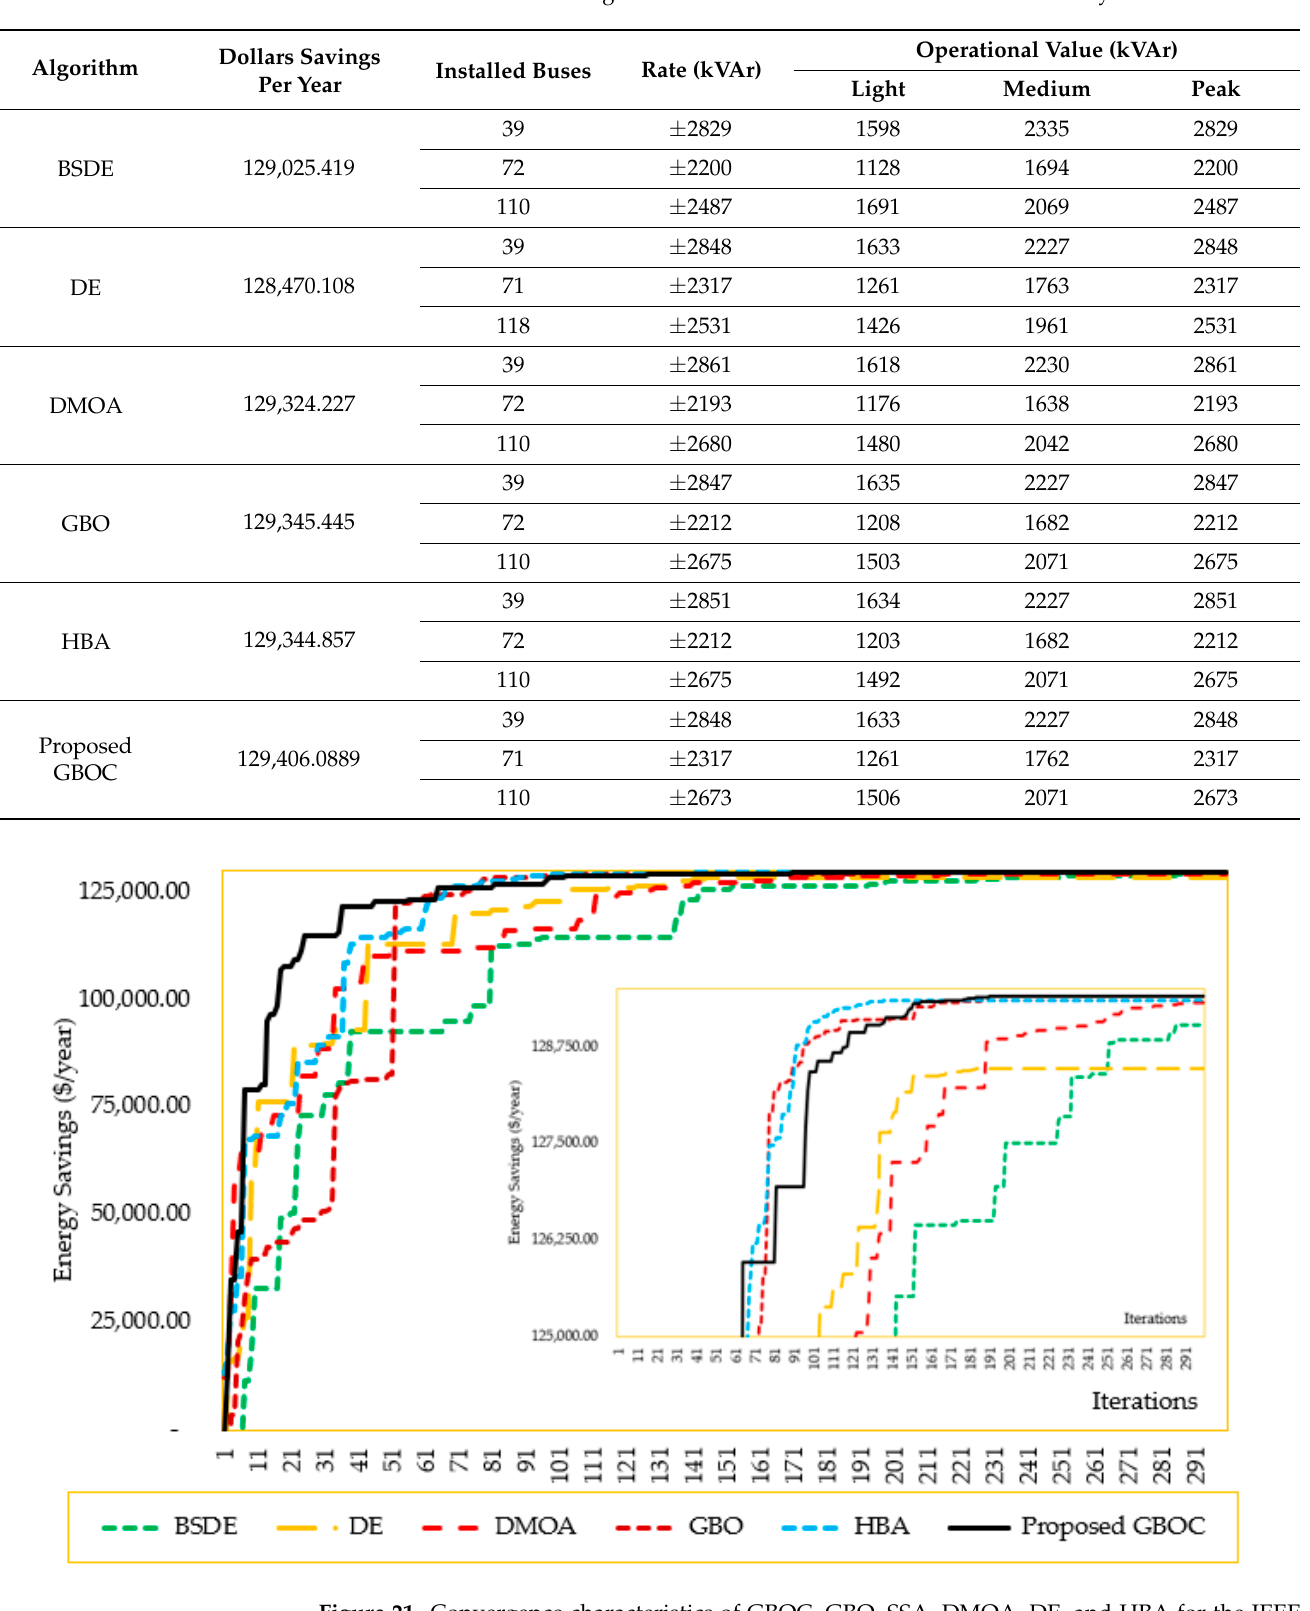
Table 8. Placement and sizing of D-SVC devices for the IEEE 119-distribution system.